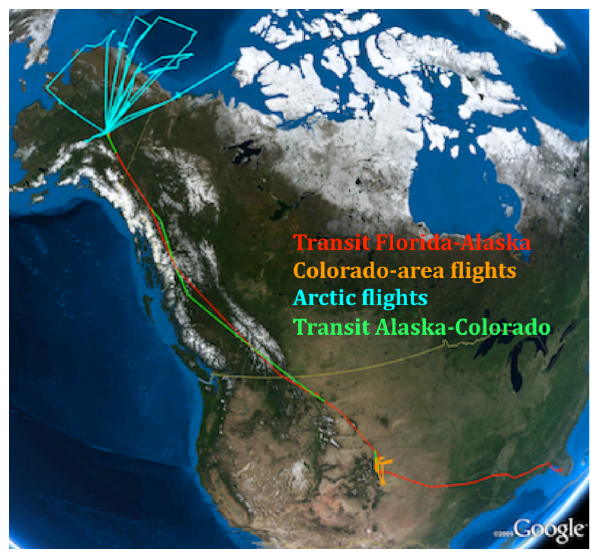
Fig. 1. Map of flight track for entire ARCPAC mission. Earth image courtesy